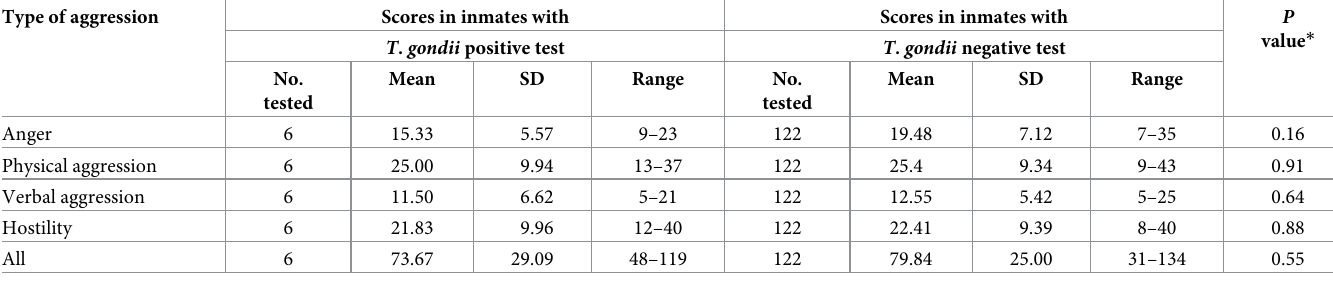
Table 3. Association between T . gondii seropositivity rates and AGQ scores. Type of aggression Scores in inmates with